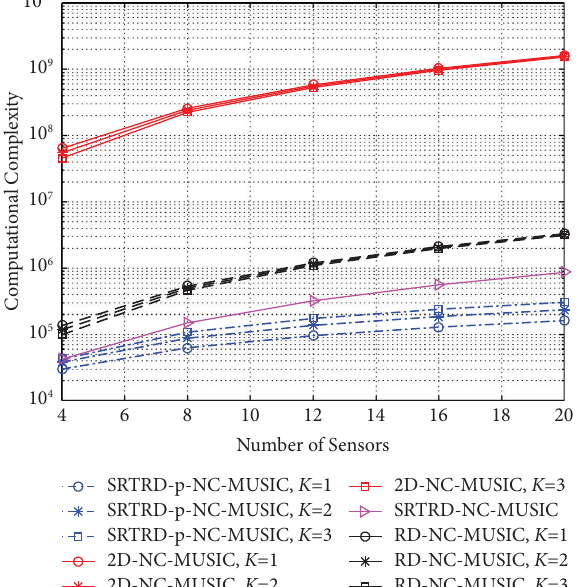
Figure 3: Comparison of computational complexities with a dif- ferent number of sensors and a diferent number of sources.